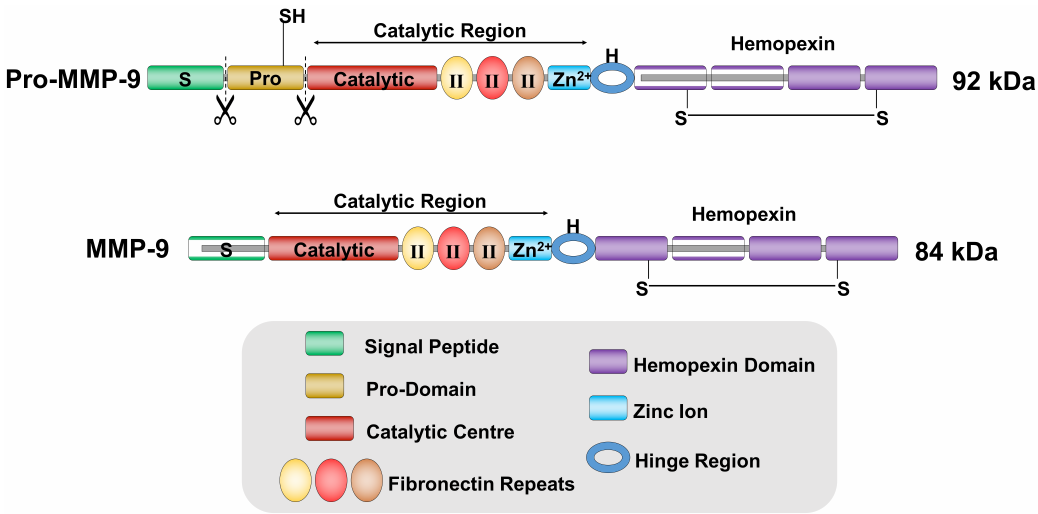
Figure 1. Protein structure of MMP-9. MMP-9 is first produced as a pro-enzyme of 92 kDa, called pro-MMP-9, containing a pro-domain of 73 aa responsible for MMP-9 catalytic latency. Subsequently, other proteases cleave pro-MMP-9 pro-domain generating the active catalytic form of MMP-9 of 84